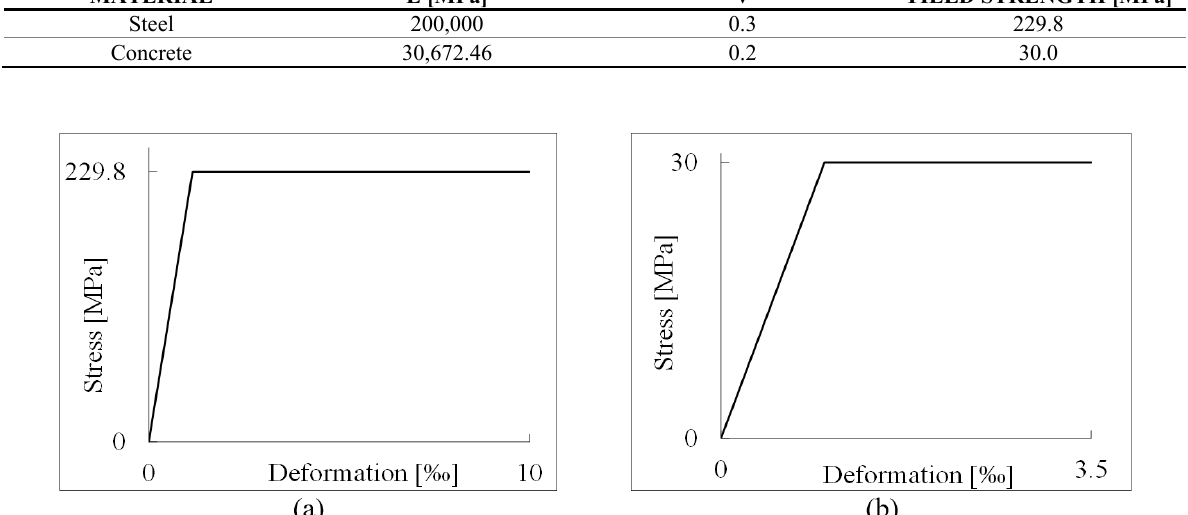
Figure 7. Stress-strain curve of steel (a) and concrete (b). Adapted from Kirchhof [24].